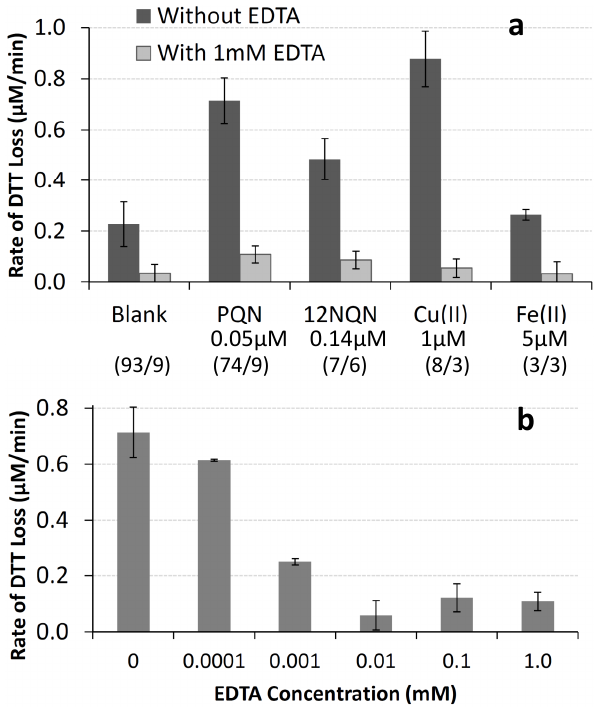
Fig. 7. Effect of EDTA on DTT loss from quinones and metals. (a) shows the average rate of DTT loss in the blank and for several compounds (at the concentrations listed) with and without 1.0mM EDTA. The rates for the quinones and metals are blank-corrected using a blank containing the same concentration of EDTA as the corresponding sample. Error bars represent ±1 σ from replicate measurements. Numbers in parentheses indicate the number of ex- periments performed without/with EDTA that are included in each average. For each sample the rate with and without EDTA are sta- tistically different at the 95% confidence limit. (b) shows the rate of DTT loss in a 0.050µM PQN solution as a function of EDTA con- centration. Each bar in (b) has been corrected using a blank with the same amount of EDTA as the